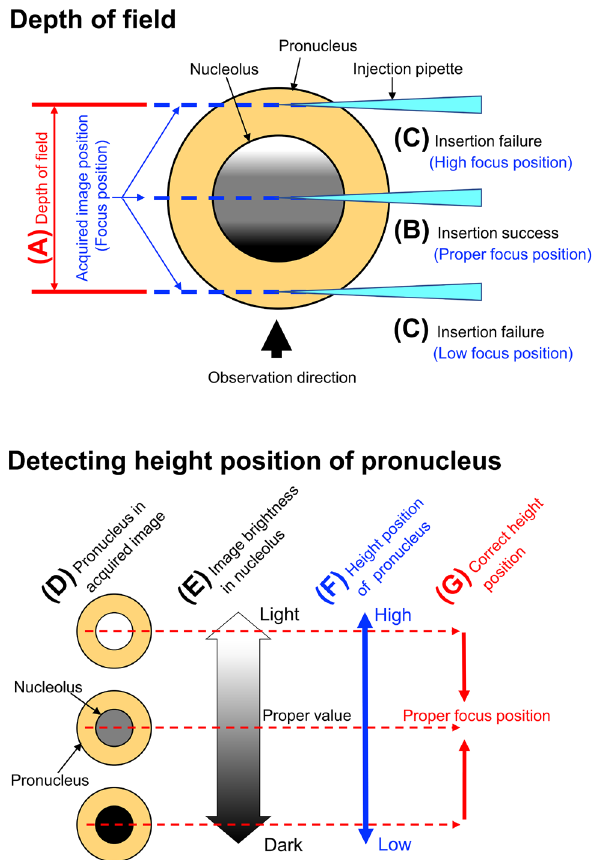
Figure 4. Procedure for detecting the height position of the center of the pronucleus during automated solution injection. ( A ) Under microscope observation, the depth of field (red arrow) varies, so the focus position of the acquired image and the height position of the pronucleus may be different each time. ( B ) If the nucleolus is identified at the proper focus position for pipette insertion, the pipette can be inserted. ( C ) On the other hand, if there is a difference in height between the focus position and pronucleus position, the nuclear membrane will not break and the pipette cannot be inserted. To ensure that the pipette is placed at the proper position, it is necessary to detect and correct the height position of the pronucleus. ( F ) From the pronucleus in the acquired image ( D ), obtain the brightness value of the nucleolus ( E ), and detect the height position of the pronucleus. ( G